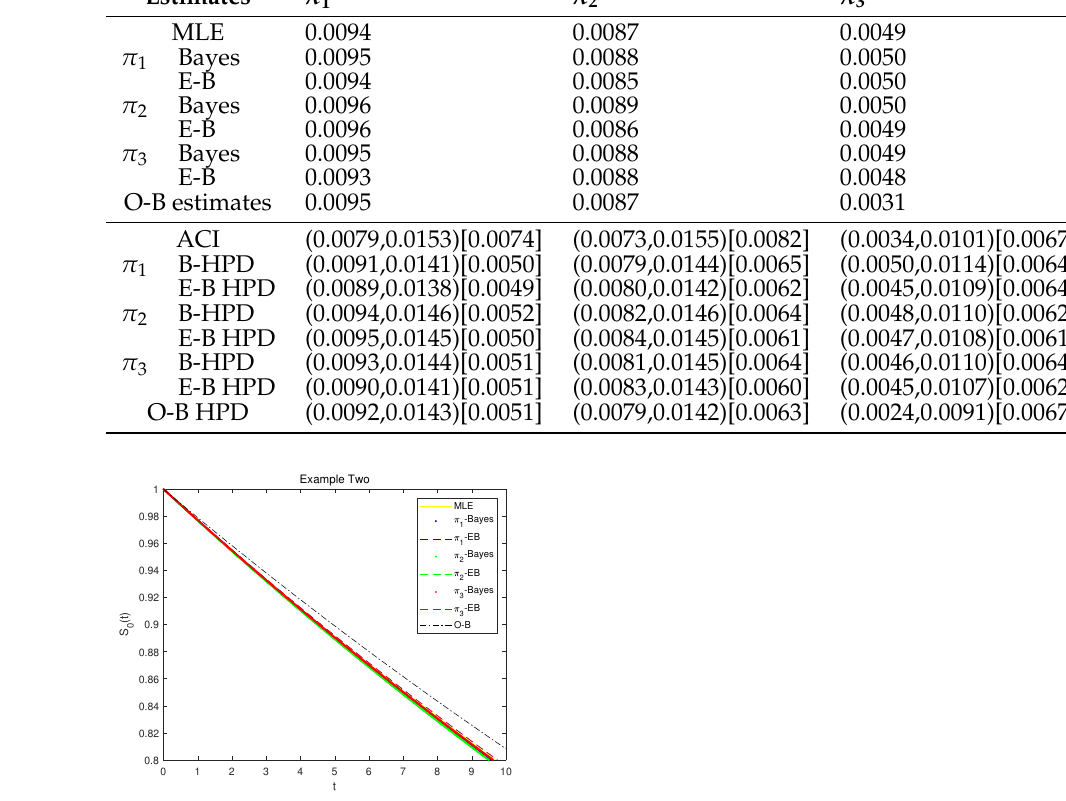
Figure 4. Plots of SF with different estimates under HIV infection